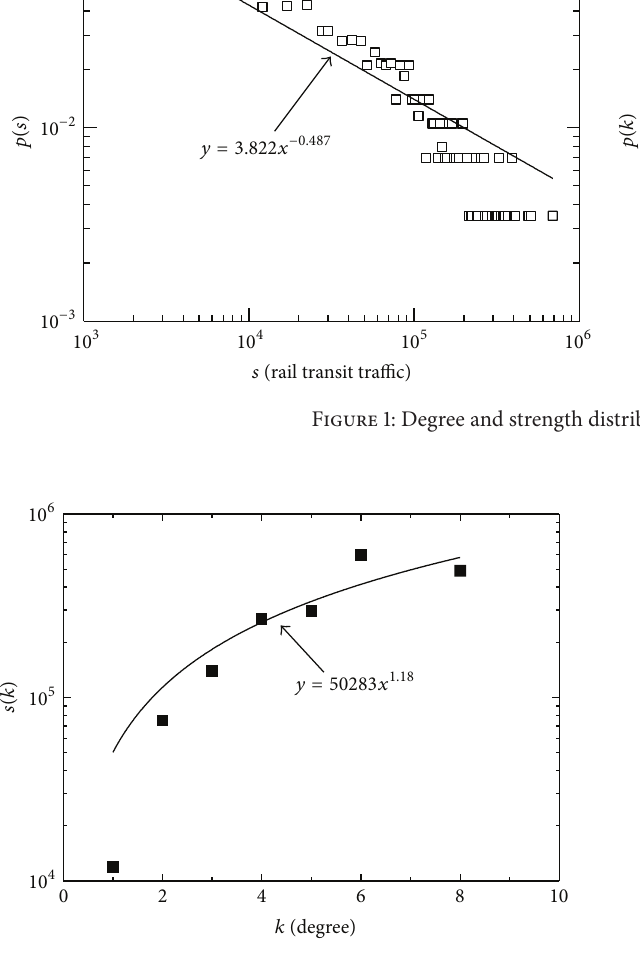
Figure 2: Average strength 𝑠(𝑘) as function of the degree 𝑘 of nodes. Figure 3: Distribution of strength as a function of the